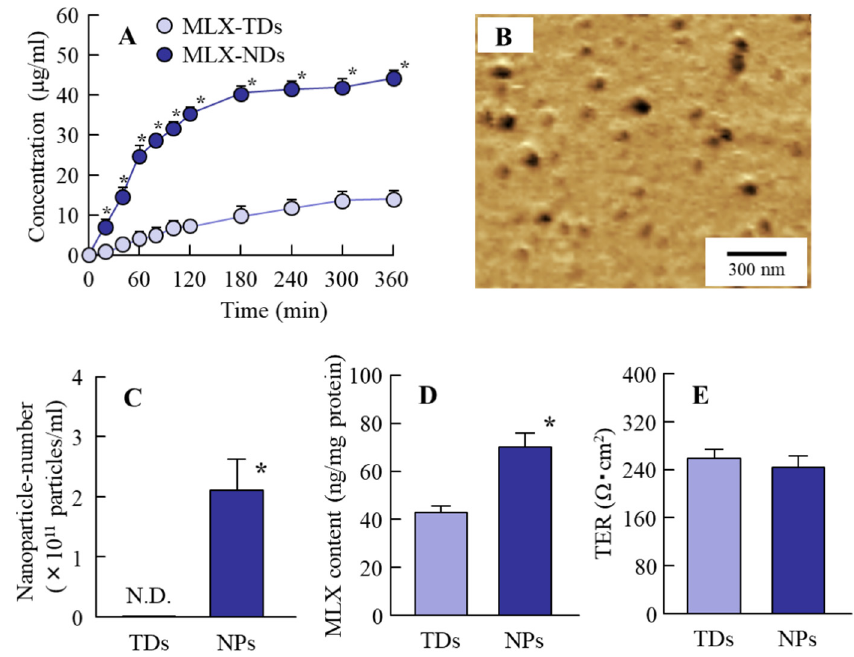
Figure 3. Trans-epithelial penetration of MLX from MLX-NPs (0.2 mg/mL) through Caco-2 cell monolayers. ( A ) Penetration of MLX formulations through Caco-2 cell monolayers. ( B ) AFM image of MLX-NPs on the basolateral side. ( C ) Number of nanoparticles from MLX-NPs on the basolateral side. ( D ) Accumulation of MLX in Caco-2 cells treated with MLX formulations. ( E ) TER of Caco-2 cell monolayers after treatment with MLX formulations. N.D., not-detected. n = 8. * P < 0.05 vs. MLX-TDs for each category. The trans-epithelial penetration and intracellular uptake from MLX-NPs were significantly higher than that from MLX-TDs, and some MLX particles passed through the Caco-2 cell monolayers as nanoparticles. Cell toxicity was similar between MLX-TDs and